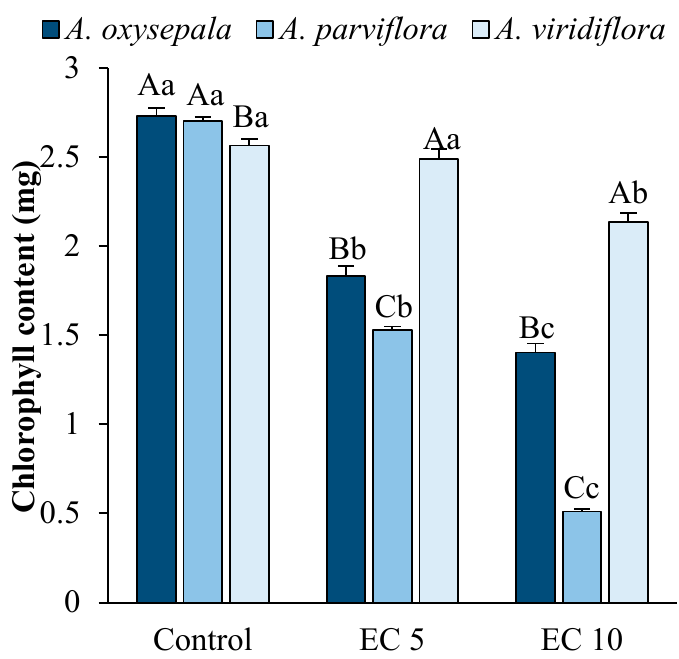
Figure 4. Chlorophyll (a+b) content of A. oxysepala , A. parviflora , and A. viridiflora irrigated with tap water (control) and salt solution at an electrical conductivity (EC) of 5 dS · m − 1 (EC 5) and 10 dS · m − 1 (EC 10). According to Tukey’s variance and analysis at p < 0.05, means with the same uppercase letters are not significantly changed among different species under the same treatment, and means with the same lowercase letters are not significantly changed among different treatments in the same species. Vertical bars represent standard error